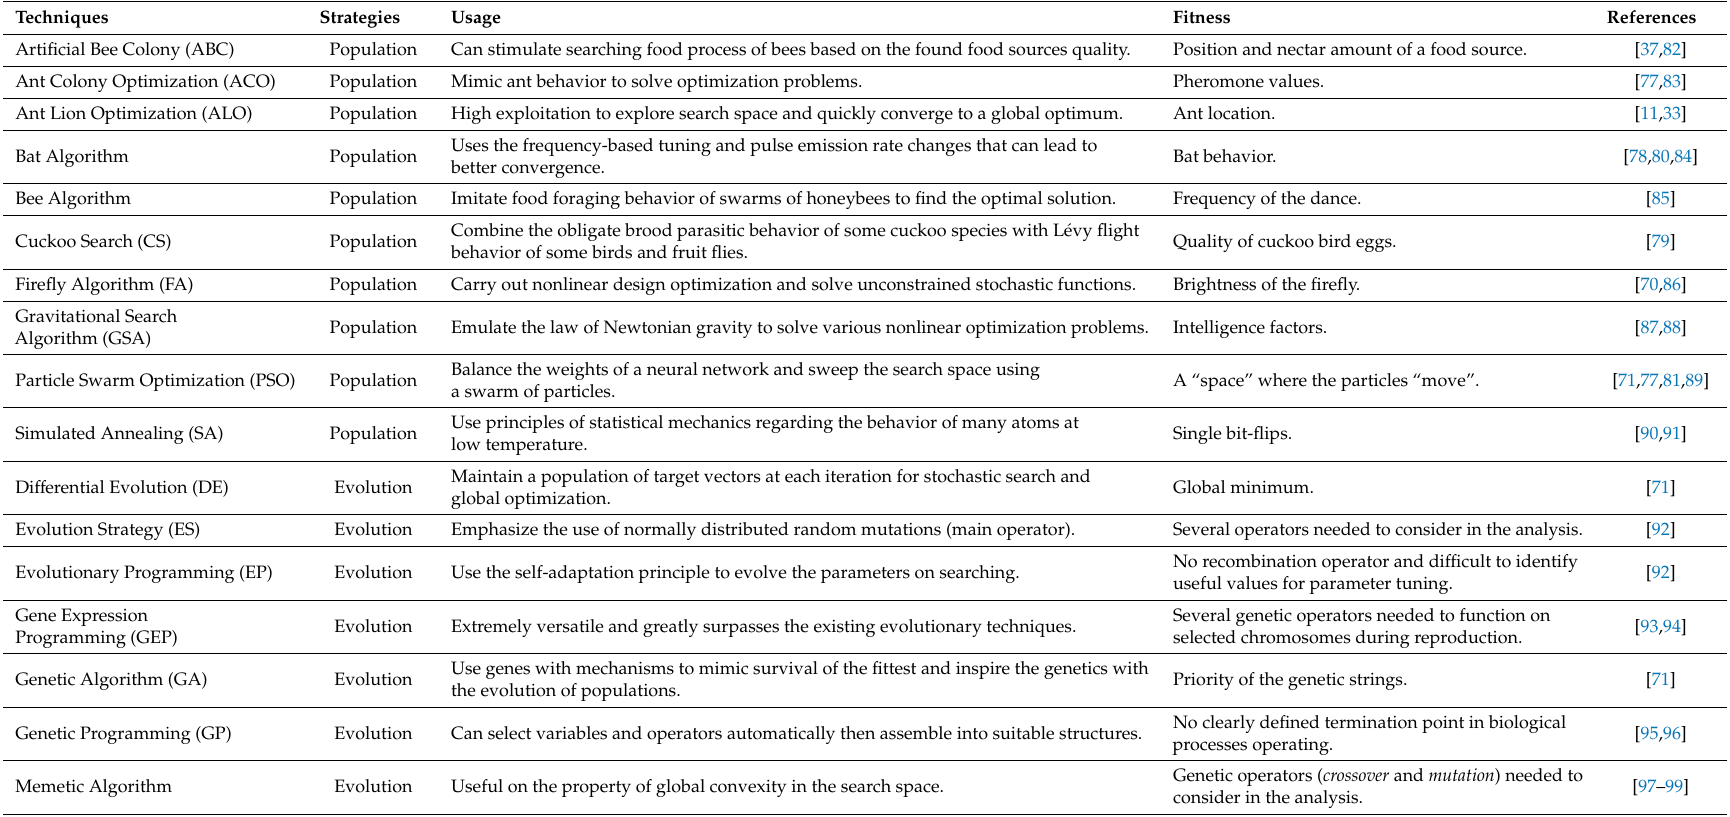
Table 5. Summary of existing techniques of swarm